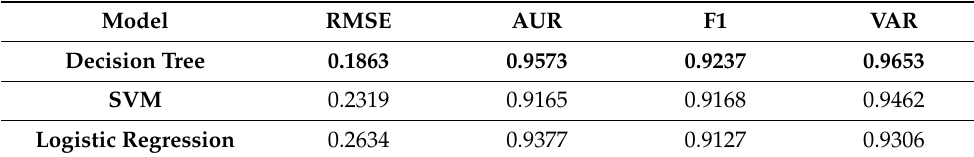
Table 1. Algorithm accuracy.